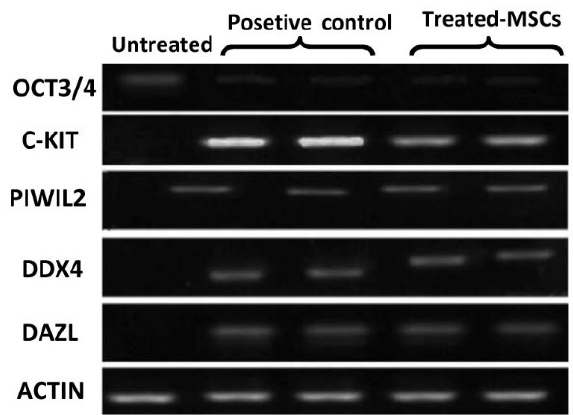
Figure 3. RT-PCR analysis of DAZL, PIWIL2, DDX4, C-KIT, and OCT3/4. Positive control: Human testicular tissue. Treated-MSCs: Treated hUMSCs after 72 h.